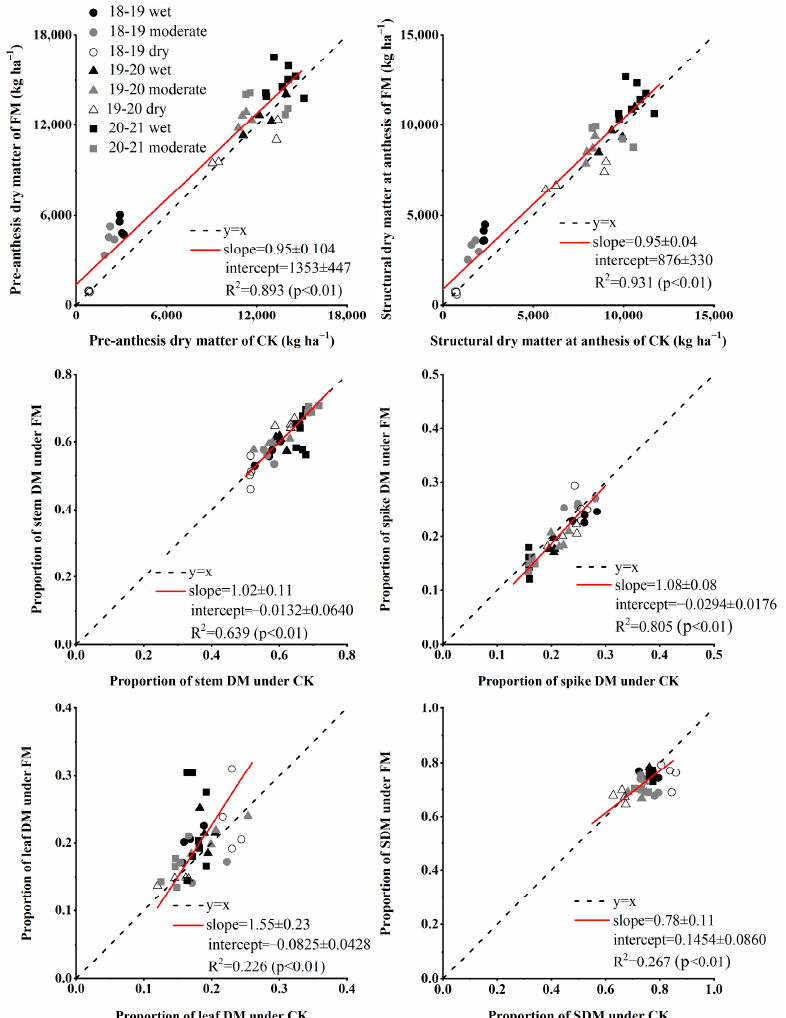
Figure 1. Comparison of pre-anthesis dry matter, structural dry matter, and proportion of various organ’s dry matter (leaf DM, stem DM, ear DM, structural DM) to above-ground dry matter (AGDM) at anthesis between plastic film mulching (FM) and bare ground (CK) wheat crops. Data including all treatments and seasons. Red solid line and equation is Model II regression accounting for error in both x and y. Standard error of slope and intercept is